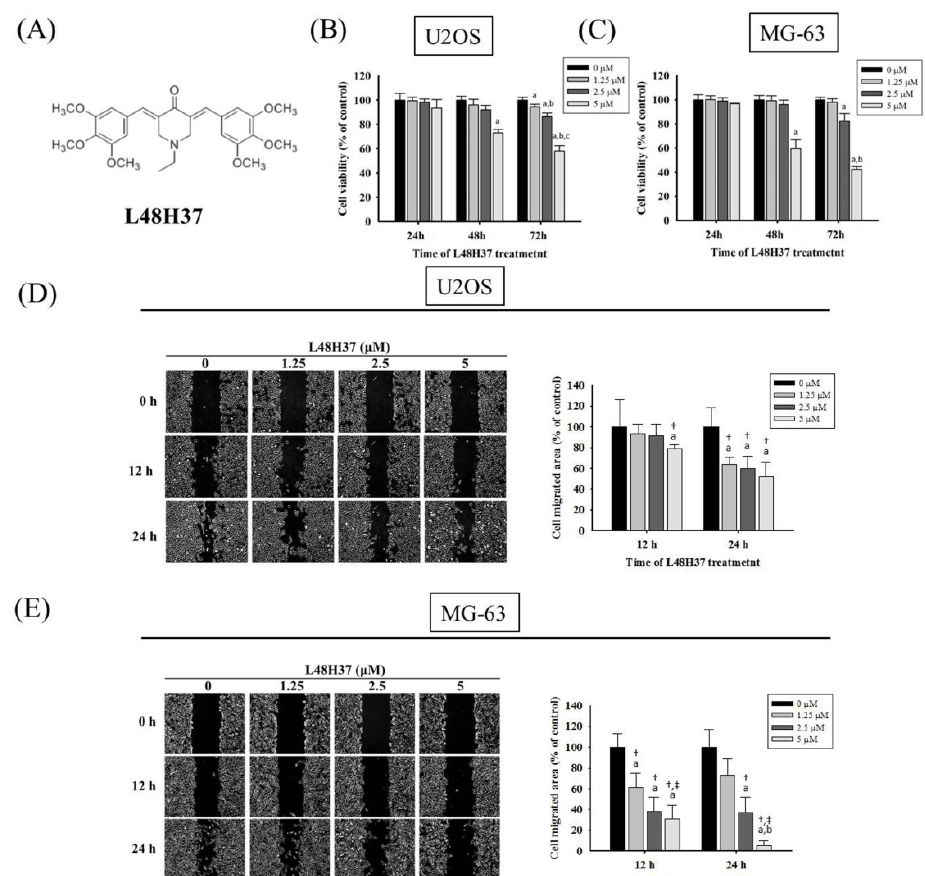
Figure 1. Effects of L48H37 on the viability of U2OS and MG-63 cells. ( A ) The structure of curcumin analogue L48H37. ( B , C ) Using an microculture tetrazolium (MTT) assay, the effects of L48H37 on the viability of U2OS and MG-63 cells treated with L48H37 (0, 1.25, 2.5, and 5 µ M) for 24, 48, and 72 h were detected and illustrated after quantitative analysis. ( D , E ) The wound-healing assay after different concentrations (0, 1.25, 2.5, and 5 μ M) of L48H37 treatment for different time intervals (0, 12, and 24 h) in U2OS and MG-63 cells were measured, as described in the Materials and Methods section, and illustrated after quantitative analysis. n = 3. ANOVA with Tukey’s post-hoc test was used. Concentration effects: U2OS: 24 h: F = 7.533, p = 0.010; MG-63: 12 h: F = 16.333, p = 0.001; 24 h: